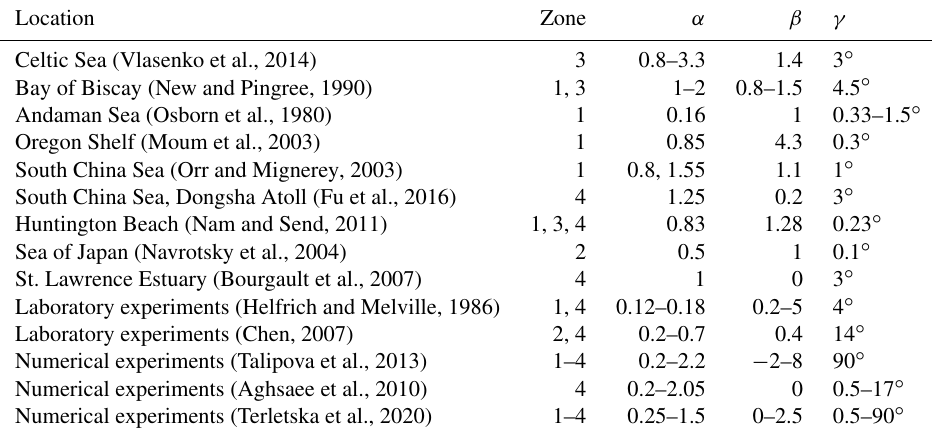
Table 2. ISW parameters from numerical experiments for the ideal- ized Lufeng region in the SCS. | a | Zone α β γ in (m) 20 2, 4 0.4 1, 3, 5 ◦ 0.4 1, 3, 5 ◦ 0.2 1, 3, 5 ◦